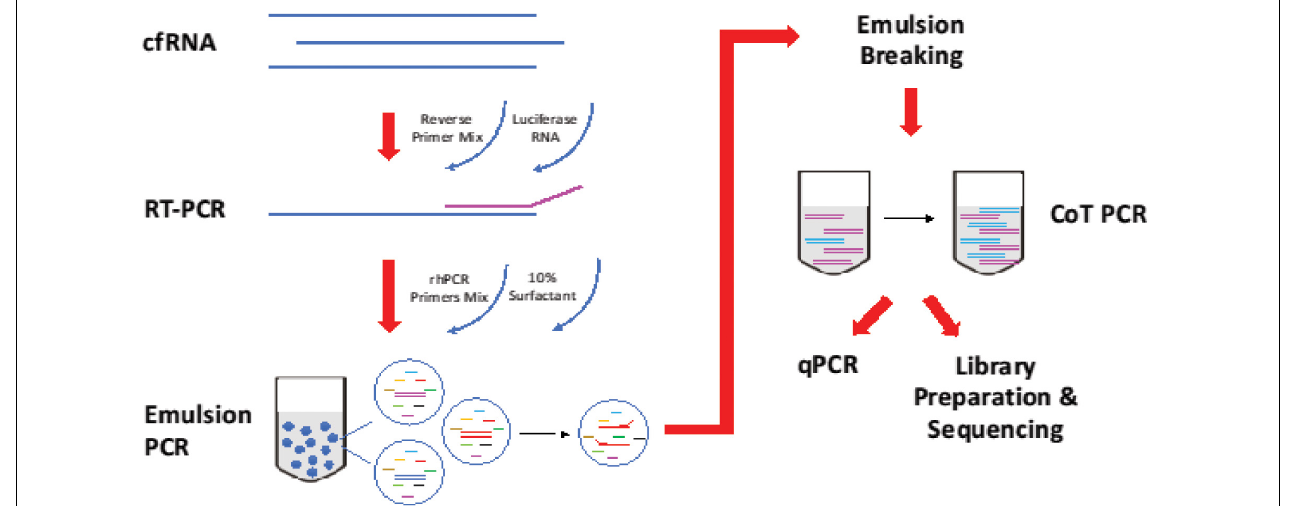
FIGURE 1 | Workflow of reverse transcription and amplification of cfRNA. cfRNA, spiked-in with luciferase RNA control, was reverse transcript with SuperscriptTM III Reverse Transcriptase (Invitrogen, Cat no. 18080044). The product was amplified with rhPCR primers and PlatinumTM Taq DNA Polymerase (Invitrogen, Cat no. 10966) using emulsion and CoT PCR. The residual primers were removed with Exonuclease I (New England Biolabs, Cat no. M0293). Amplified products were used for qPCR quantification and